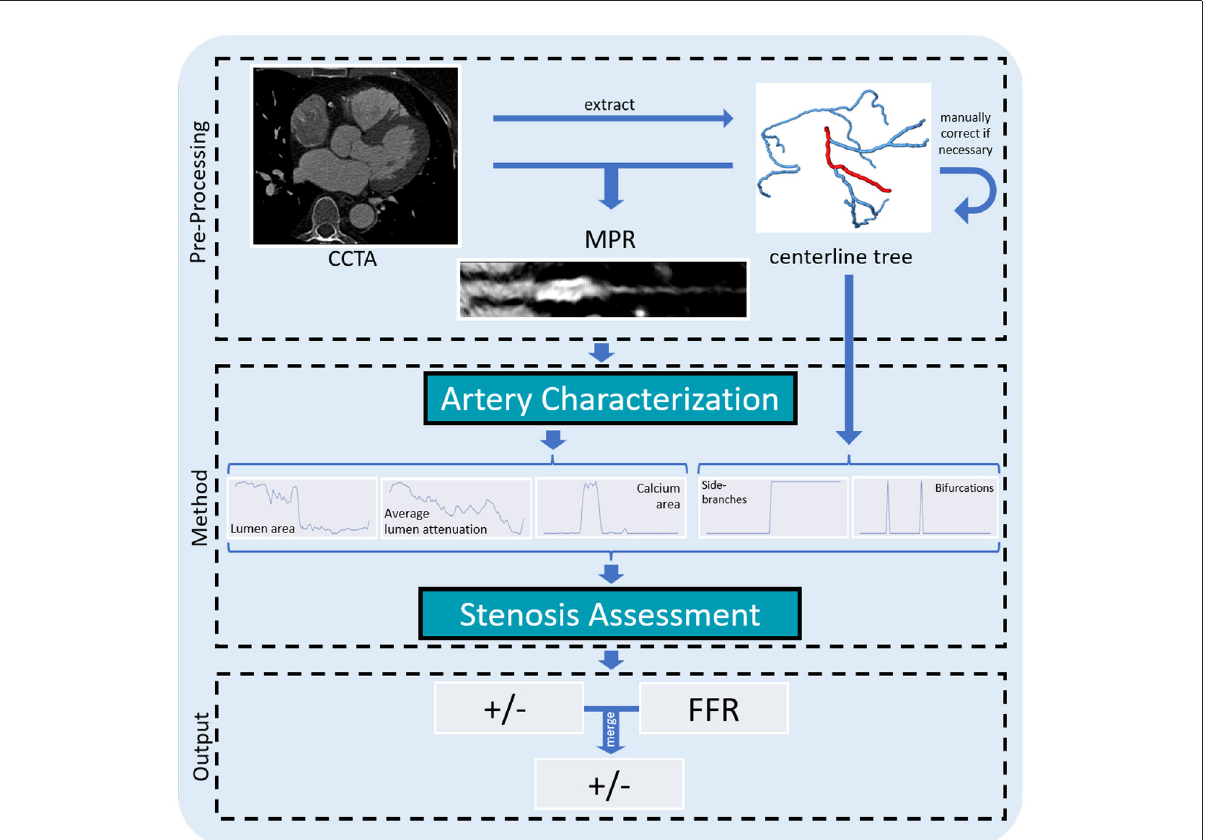
FIGURE2 Overview of our method for assessing the presence of a functionally significant stenosis in a coronary artery. From the CCTA scan, we extract a coronary artery centerline tree. For each artery we generate an MPR that is further analyzed to predict the lumen area, its average attenuation and the calcium area per centerline point. These characteristics, as well as characteristics indicating the presence of bifurcations and whether the artery is a main branch or to a side branch of a main artery, are fed to the classification network to determine the presence of a functionally significant stenosis in the